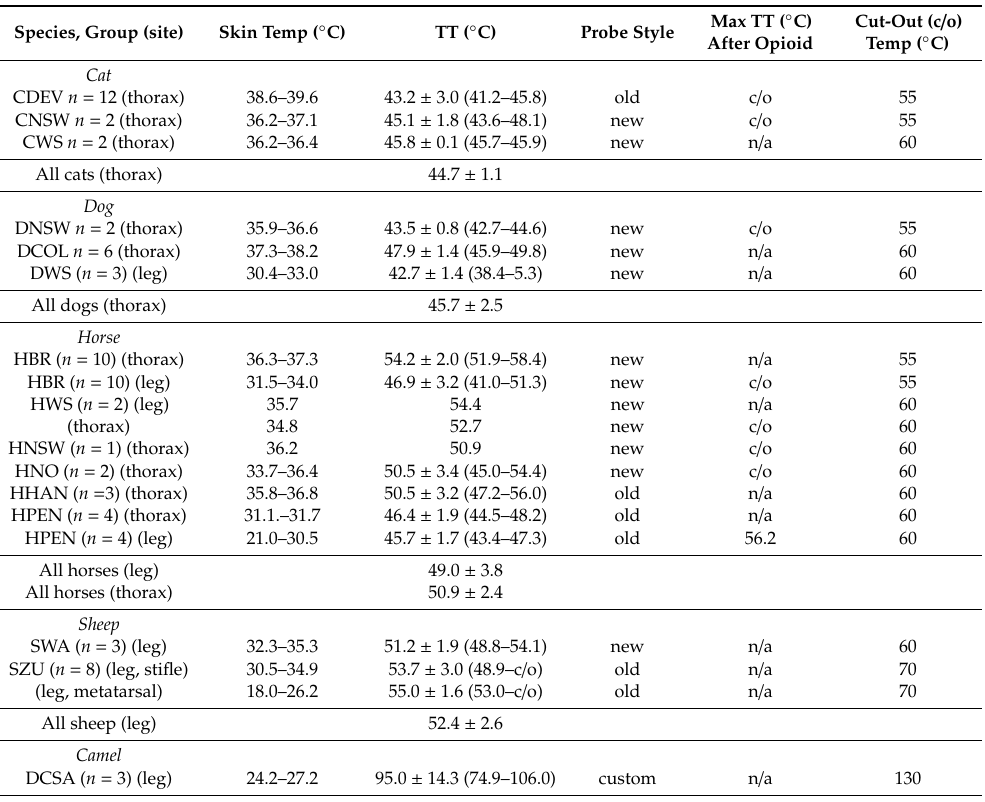
Table 1. Skin temperature ( ◦ C) (range) and thermal nociceptive threshold ( ◦ C) (TT) (mean ± SD (range)) recorded with a remote controlled system during training in cats, dogs, sheep, horses and